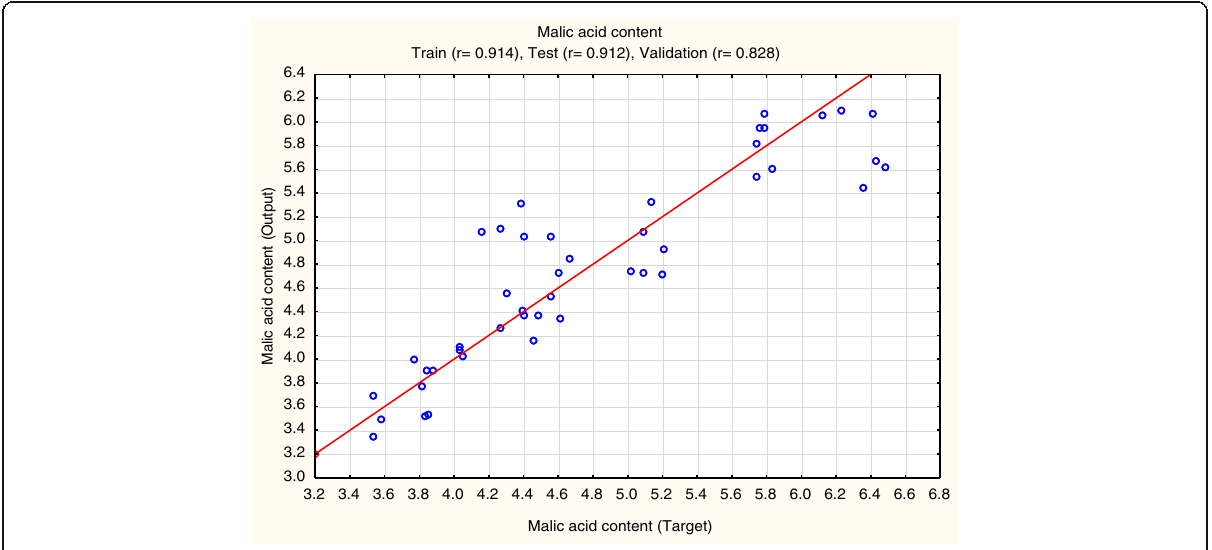
Fig. 3 Correlation between target (observed) and output (simulated) concentrations of malic acid using ANN model